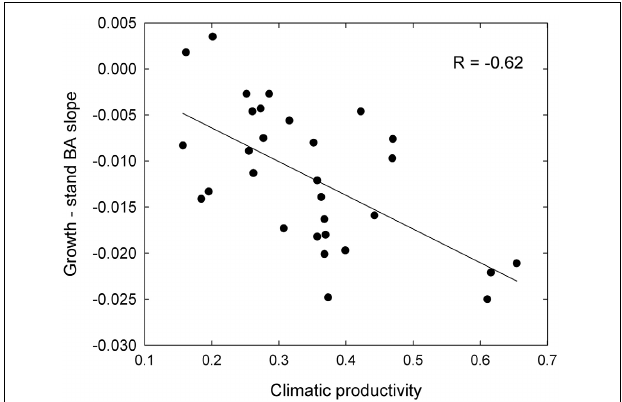
FIGURE 8 | Relationship between growth sensitivity to stand BA (growth—stand BA slope) and climatic productivity, for eucalypts < 30cm